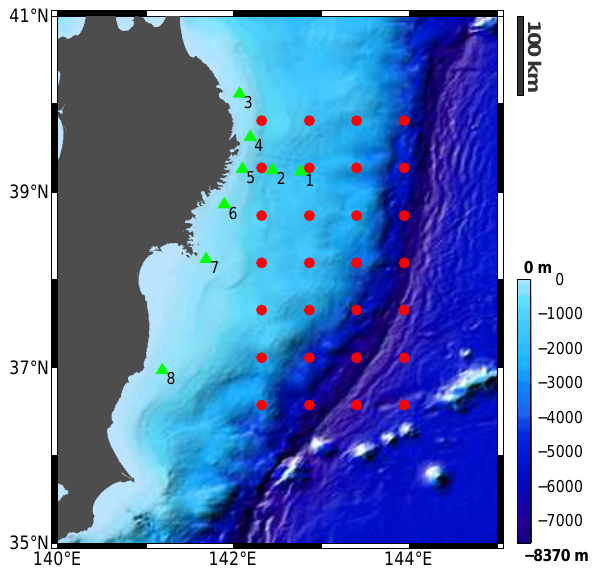
Figure 2. Study area and bathymetry profile. Red dots indicate unit sources located throughout the inverse region. Green triangles with numbers are artificial observation stations.